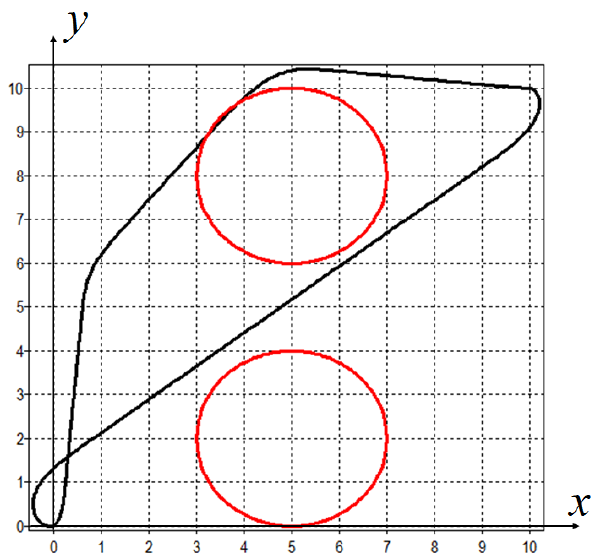
Figure 6. Trajectories of robots obtained by direct